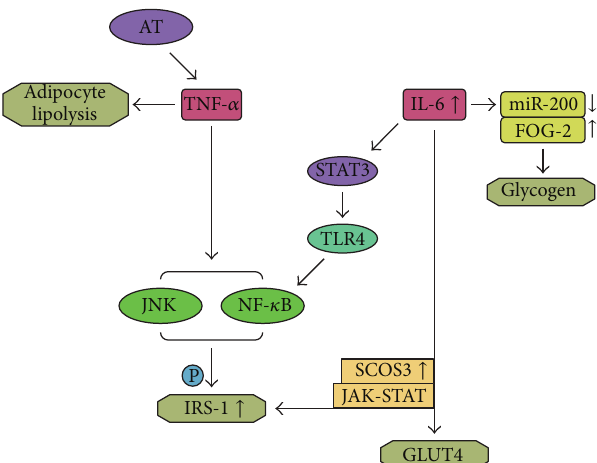
Figure 1: Influence of the inflammatory cytokines on the status of insulin resistance. TNF- 𝛼 causes insulin resistance by enhancing adipocyte lipolysis stimulating JNK and IKK 𝛽 /NF- 𝜅 B pathway which may increase serine/threonine phosphorylation of IRS1. IL-6 induces IR by reducing the expression of GLUT4 and IRS-1 by activating the JAK-STAT signaling pathway and increasing SOCS3 expression, and IL-6 can also lead to IR in skeletal muscle by inducing TLR-4 gene expression through activation of STAT3; besides, TLR4 is suggested to be major upstream molecules in the activation of NF- 𝜅 B. Besides, IL-6 is also found to induce IR by impairing the synthesis of glycogen through downregulating the expression of miR-200s and upregulating that of